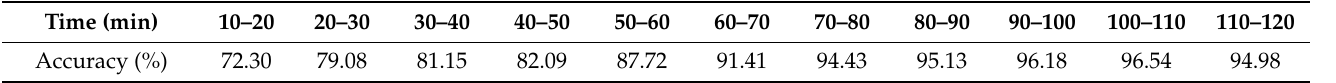
Table 3. Accuracy results of HRV index with random forest